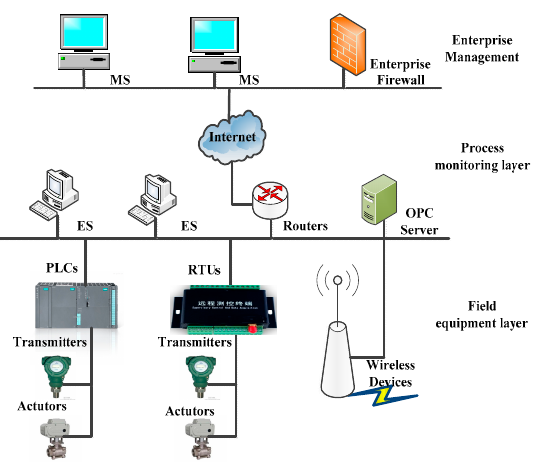
Figure 3. The structure of an ICPS.